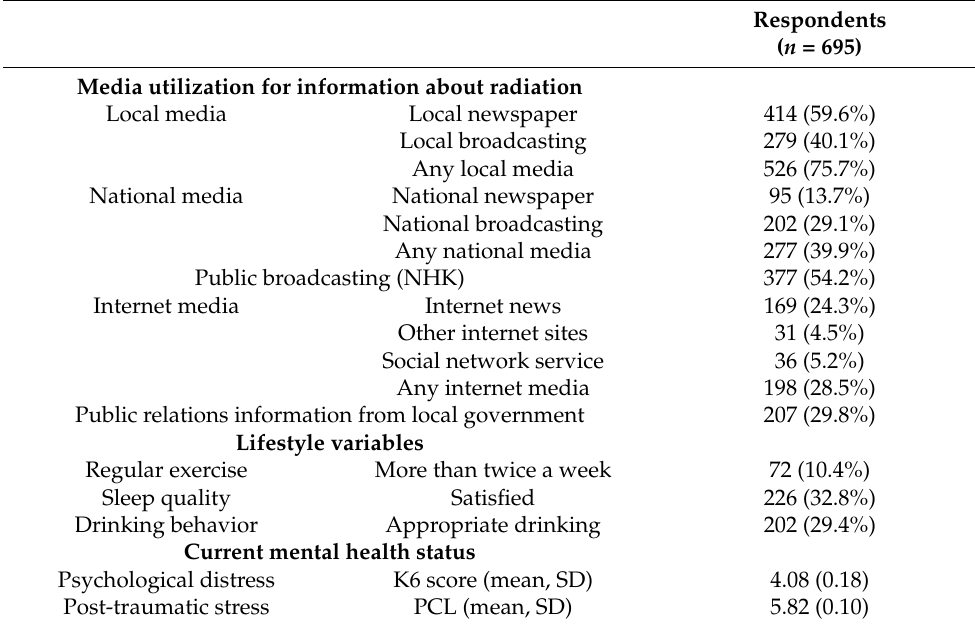
Table 2. Media utilization, lifestyle variables, and current mental health status of